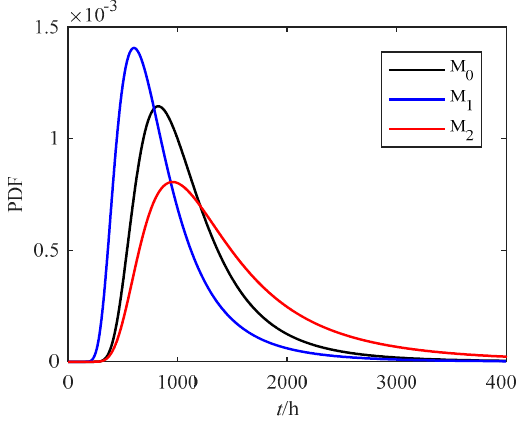
Figure 7. Comparison of PDF of storage lifetime at 50 °C for O-type rubber seal rings.